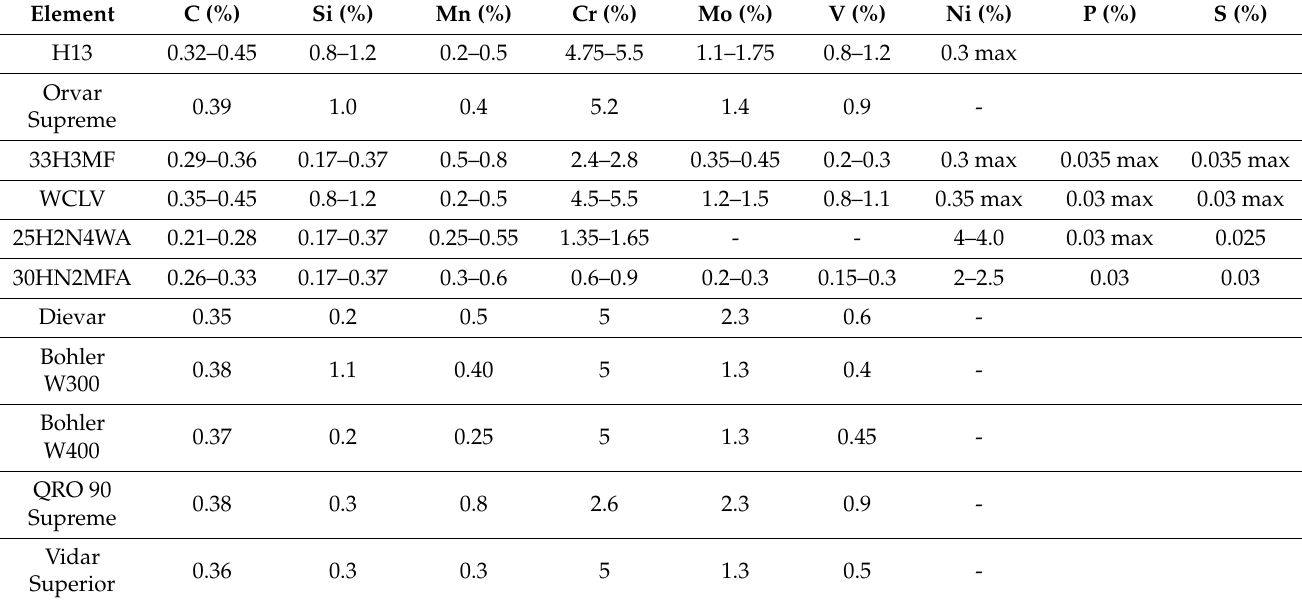
Table 5. Comparable hot work steels’ chemical